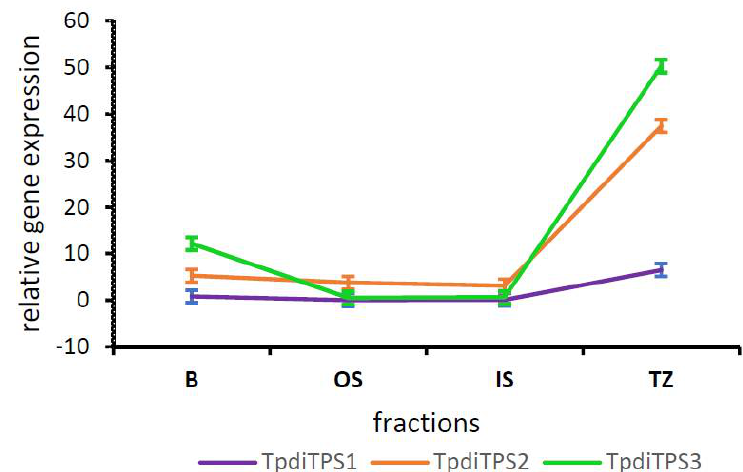
Figure 2. TpdiTPS2 and 3 are expressed at elevated levels in the sap to heartwood transition zone. Expression of TpdiTPS1, 2, and 3 in RNA-seq libraries derived from four di ff erent fractions of Western redcedar (WRC) wood. B—bark, OS—outer sapwood, IS—inner sapwood, TZ—sapwood to heartwood transition zone. Error bars were calculated based on two biological replicates. TMM (trimmed mean of M-values) normalized TPM (transcripts per million) values were used to calculate relative expression levels. Statistical di ff erences of expression in di ff erent fractions were determined in R (version 4.0.1) by two-way ANOVA and Tukey HSD tests. To identify possible functions, we compared the putative catalytic motifs in TpdiTPS1, 2, and 3 (Figure 3) with the DXDD motif in the N-terminal domain indicative of a class II terpene synthase